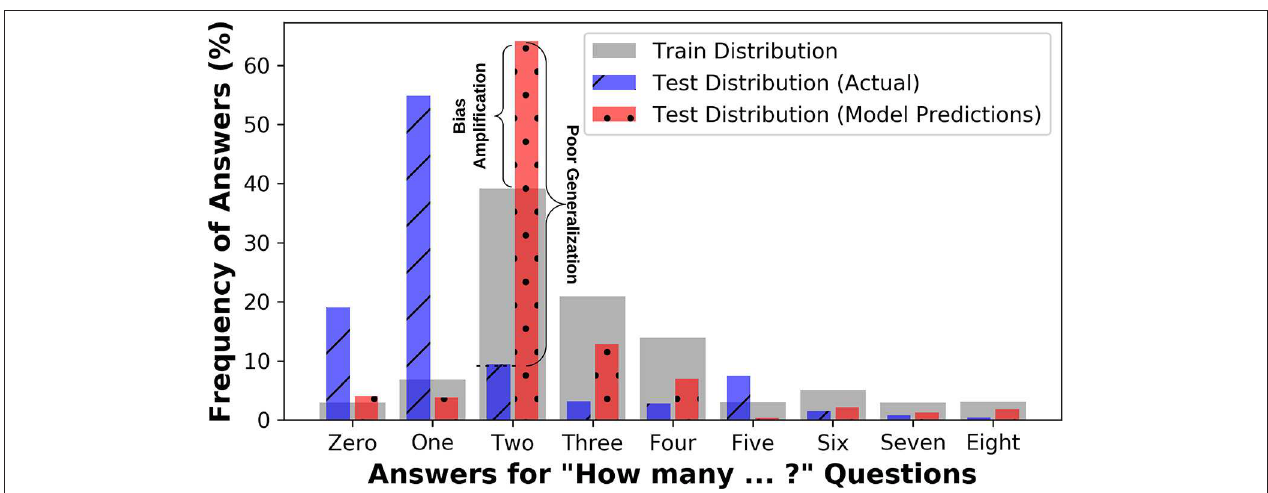
FIGURE 2 | Answer distribution for questions starting with the phrase “How many” in the train and test splits of VQA-CP dataset (Agrawal et al., 2018), alongside the test-set predictions from a state-of-the-art VQA model, BAN ( Kim et al., 2018). In VQA-CP, the distribution of test set is intentionally made different from the training set to assess if the algorithms can perform well under changing priors. Algorithms not only fail to perform well under changing priors, but they also demonstrate bias-amplification, i.e., the predictions show increased bias toward answers that are more common in the training set than the actual level of